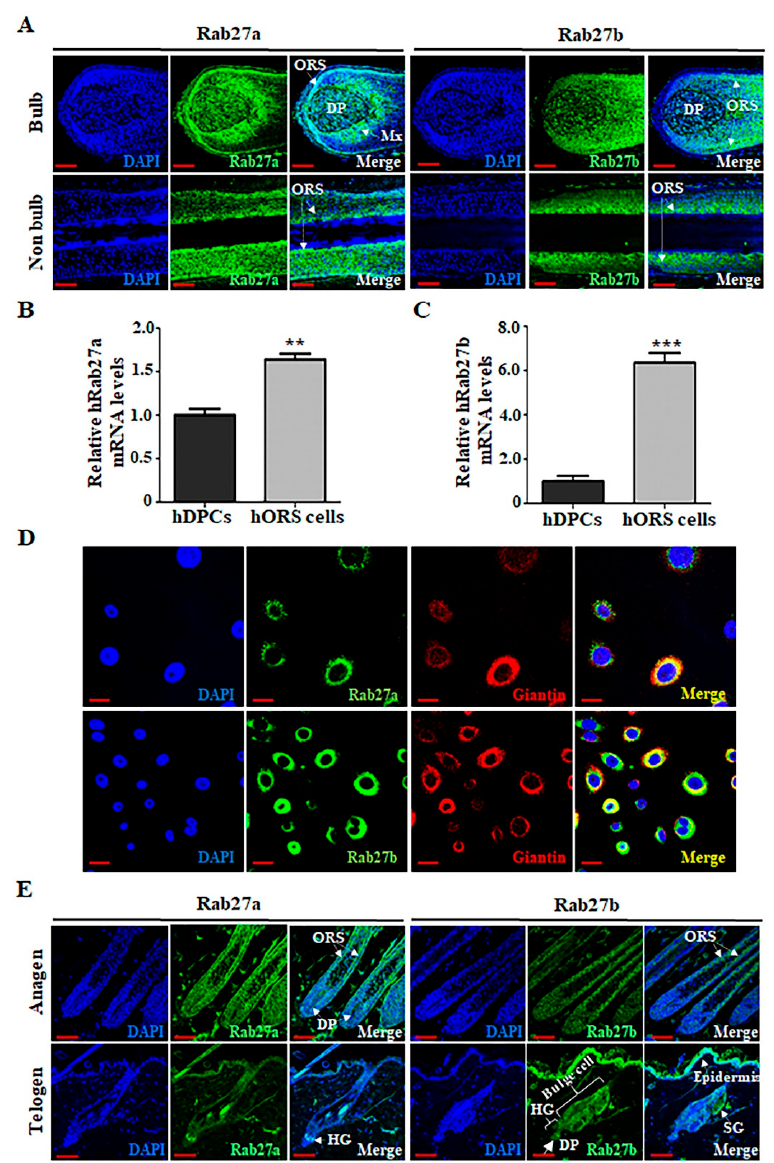
Figure 1. Rab27a and Rab27b are mainly distributed in the outer root sheath (ORS) cells of the hair follicles (HFs) during the anagen phase, both of which are expressed in the Golgi apparatus of hORS cells. ( A ) In human HFs at the anagen phase, Rab27a is mainly distributed in hORS cells and matrix cells (Mx) and is also slightly distributed in hDPCs in the bulb region. In addition, Rab27a was mainly distributed in hORS cells in non-bulb regions. And Rab27b was also mainly distributed in ORS cells in both bulb regions and non-bulb regions. ( B ) The expression level of hRab27a mRNA was increased 1.6-fold in hORS cells compared with that in hDPCs. ( C ) The expression level of hRab27b mRNA was increased 6.4-fold in hORS cells compared with that in hDPCs. ( D ) Both Rab27a and Rab27b were expressed in the Golgi apparatus in hORS cells. ( E ) In mouse HFs at anagen phase, mouse Rab27a/b are mainly distributed in the ORS cells of HFs. However, during the telogen period, mouse Rab27a was mainly expressed in hair germ (HG), and mouse Rab27b is strongly expressed in the epidermis and epidermal compartment, including bulge, HG, and sebaceous gland (SG). hDPCs; human dermal papilla cells, hORS cells; human outer root sheath cells, Mx; matrix cells. Scale bars indicate 50 µ m ( A , E ) and 20 µ m ( D ). ** p < 0.01, *** p < 0.001 using Student’s t test. Three independent experiments were conducted. All error bars indicate